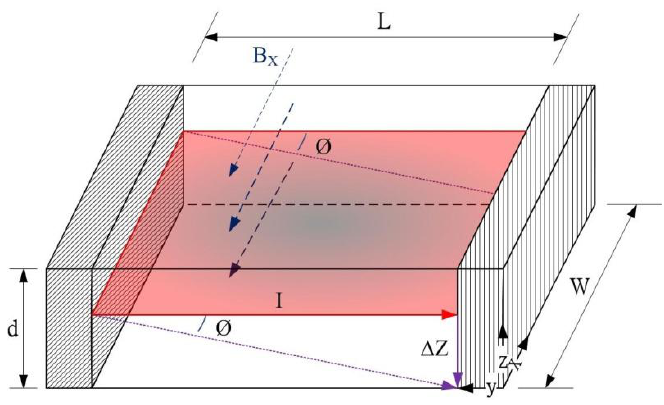
Figure 1. Current deflected by the magnetic field of the x